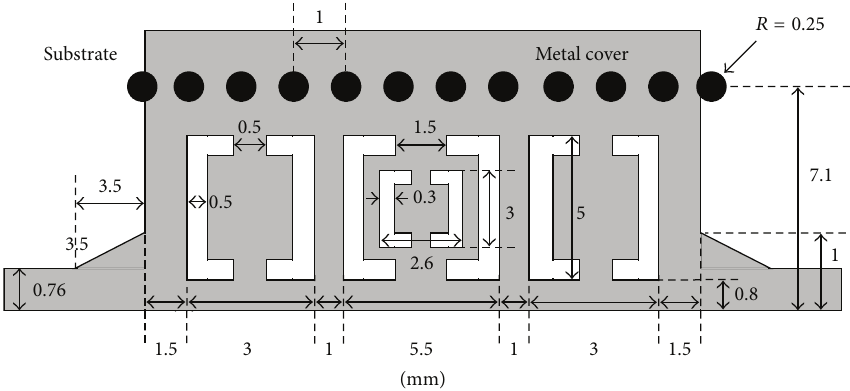
Figure 7: Geometrical configuration and dimensions of proposed HMSIW-DGS filter.